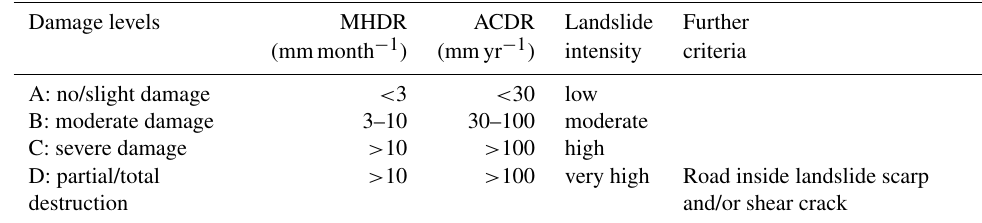
Table 9. Damage criteria as a function of landslide velocity (MHDR: maximum monthly horizontal displacement rate; ACDR: annual cumulative horizontal displacement).